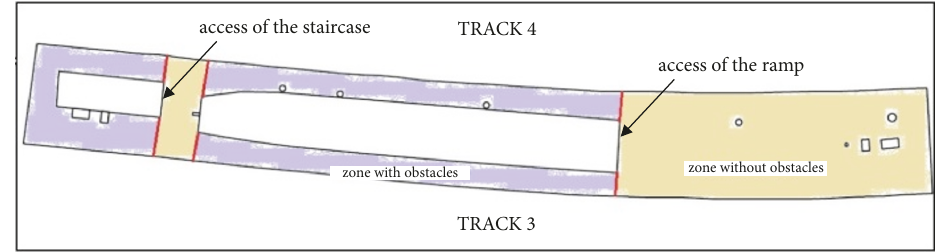
Figure 5: Layout of the study area: platform 3/4 in Bern railway station. The safety line is not represented in the figure.